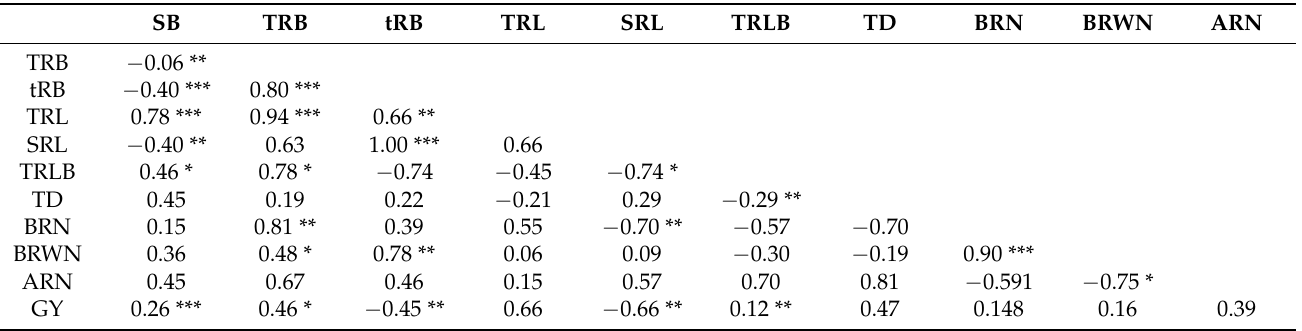
Table 3. Correlation coefficients ( r ) among measured